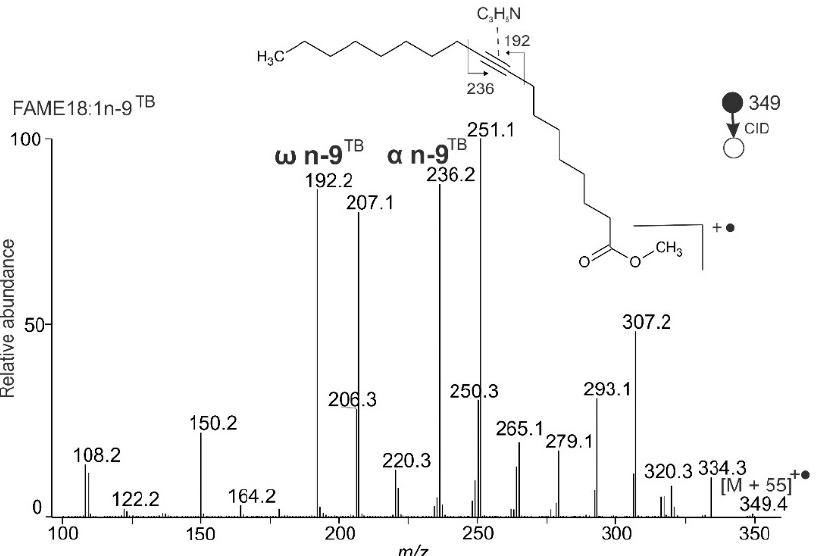
Figure 3. APCI MS/MS CID spectrum of [M + 55] + • adduct of stearolic acid methyl ester (FAME 18:1n-9 TB ); MBR = 236 + 192 − 349 = 79.